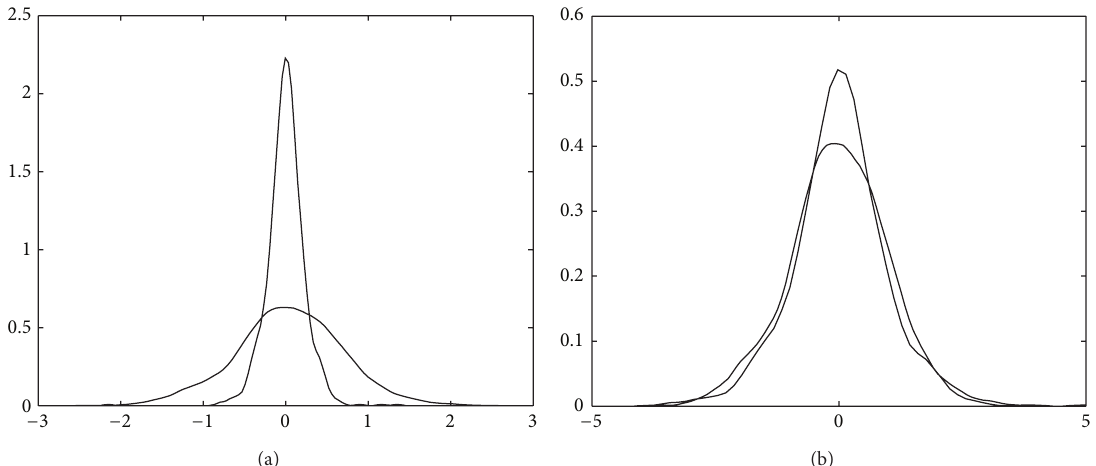
Figure 2: Last 𝑛 = 904 observations of the pair (4, 5) in the Oil currency data set. (a) estimated densities and (b) estimated standardized densities.